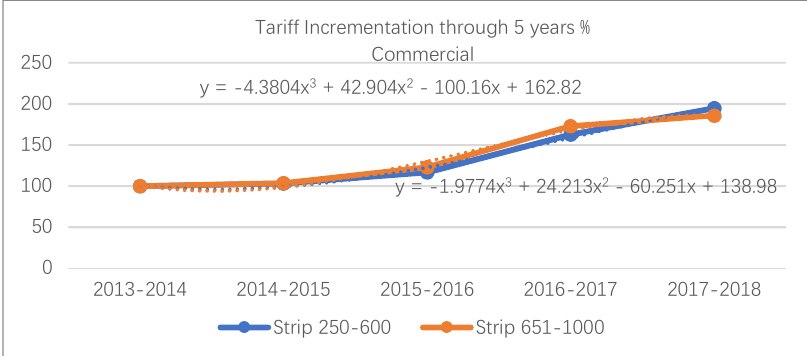
Figure 9. Percentage incrementations in case of commercial loads.